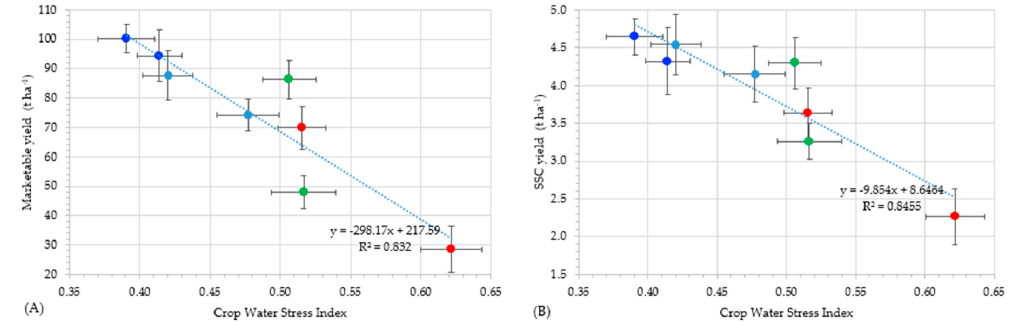
Figure 5. The relationship between the water stress values and marketable yield (R 2 = 0.83) ( A ) and SSC yield (R 2 = 0.85) ( B ). The vertical and horizontal bars represent the standard error. The relationship between SSC yield and water stress levels are similar to the previous but it gives slightly better fit with the regression line. The relationship between the two factors is slightly better than the previous R 2 = 0.85, at p = 0.001 significance level (Figure 5B). The two models are basically the same. When the stress is above 0.51 average CWSI, the SSC yield drops below 4 t ha − 1 . Considering comprehensive tomato growth modelling results, other researchers suggested that the optimal water supply might be around 60–70% of crop evapotranspiration in the future, because of the predicted effects of climate change and heat stress identification will reduce irrigation water availability. The study emphasized the beneficial effects of moderate water stress during the ripening stage of tomato [59]. The increasement in dry yield induced by water deficit can be genotype dependent as well and not only the effect of water deficit [60]. 3.6. Effect of Water Supply and Season on Lycopene A two-way ANOVA was also conducted to analyze the effect of water supply on the lycopene concentration in the fruits. The results revealed that both year and treatment and also their interaction had significant effect on tomato’s most important carotenoid ( p < 0.01). When examined the means of the two-year values, we noticed that the water stress levels had a clear effect on carotenoid content of tomato. There is a significant difference between treatments as showed in Figure 6.